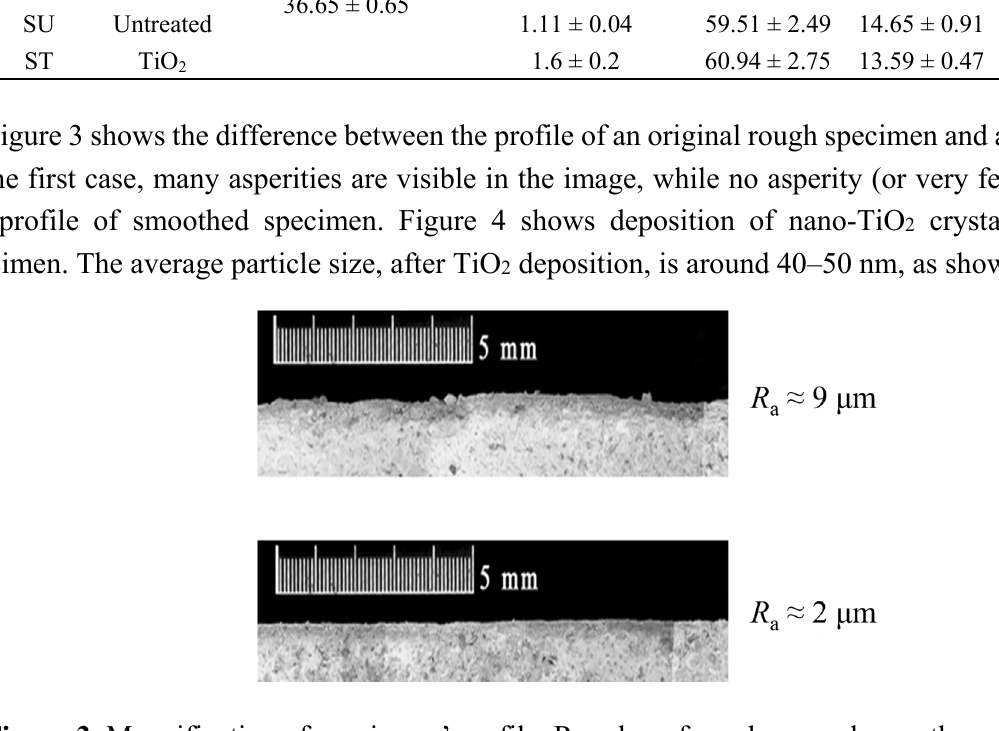
Figure 3. Magnification of specimens’ profile. Rough surface above and smooth surface bottom.